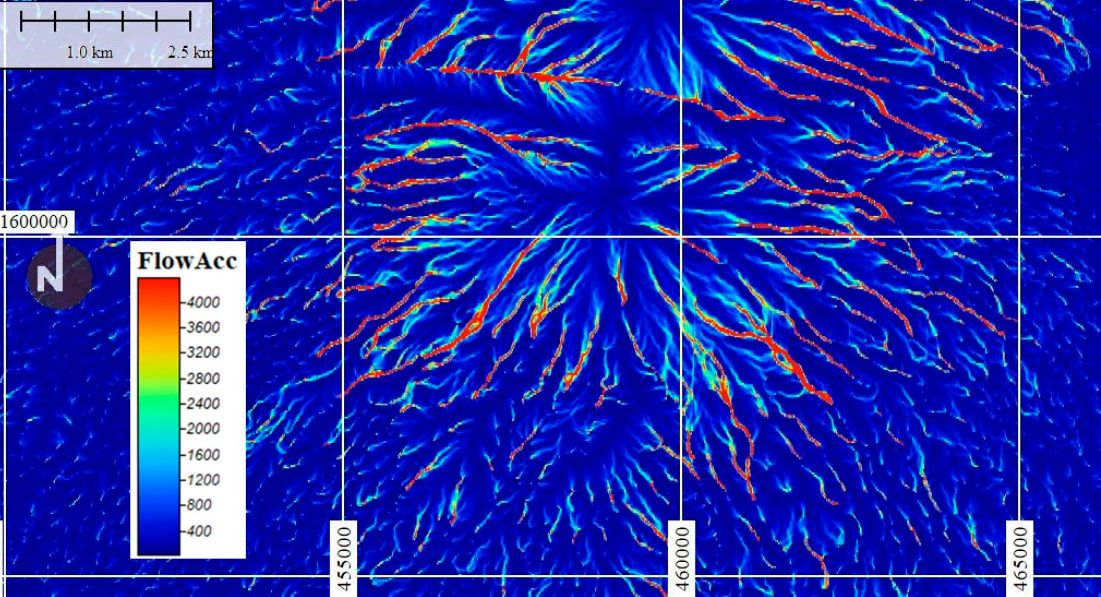
represent greater accumulations of flow and areas of concentrated flow that can be used to identify 433